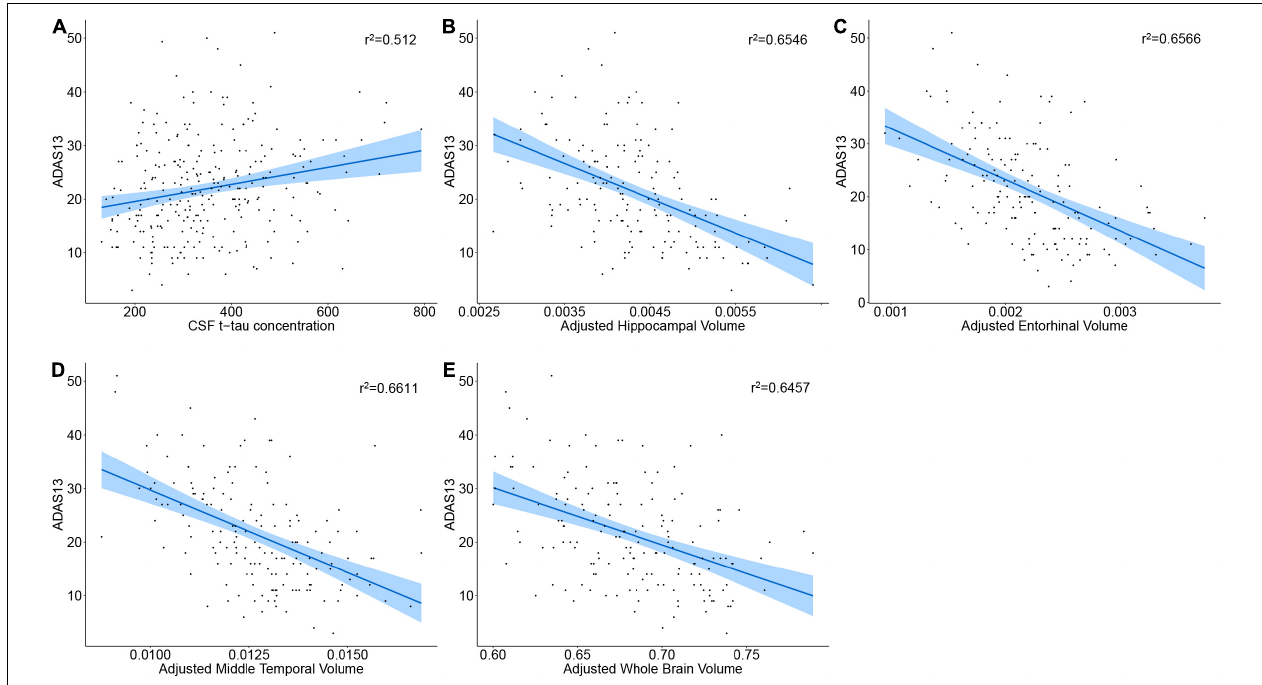
FIGURE 2 | Correlation of baseline CSF proteins or brain volumes with cognition status. (A–E) The regression plot of CSF proteins or brain volumes. Note that the brain volumes were segmented from 3.0 T structural MRI.